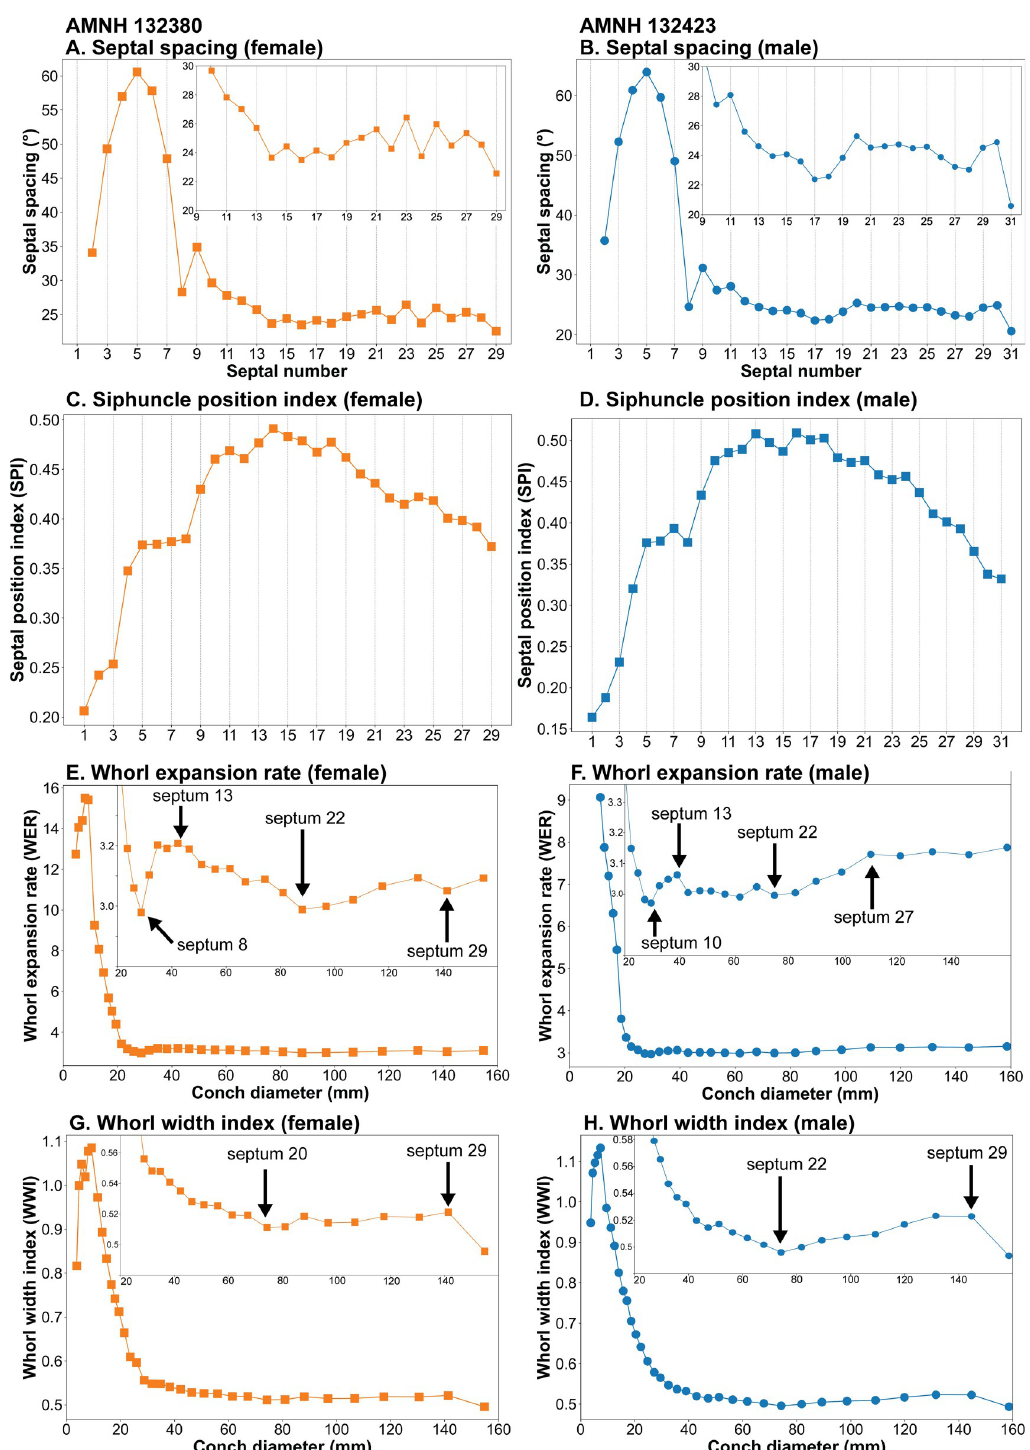
Fig 6. Morphological parameters in Nautilus macromphalus . Septal spacing for AMNH 132380 (female) (A); septal spacing for AMNH 132423 (male) (B); siphuncle position index (= vd/wh) for AMNH 132380 (female) (C); siphuncle position index (= vd/wh) for AMNH 132423 (male) (D); whorl expansion rate [= (dm 1 /dm 2 ) 2 ] for AMNH 132380 (female) (E); whorl expansion rate [= (dm 1 /dm 2 ) 2 ] for AMNH 132423 (male) (F); whorl width index (= ww/dm) for AMNH 132423 (male) (G); whorl width index (= ww/dm) for AMNH 132423 (male) (H).